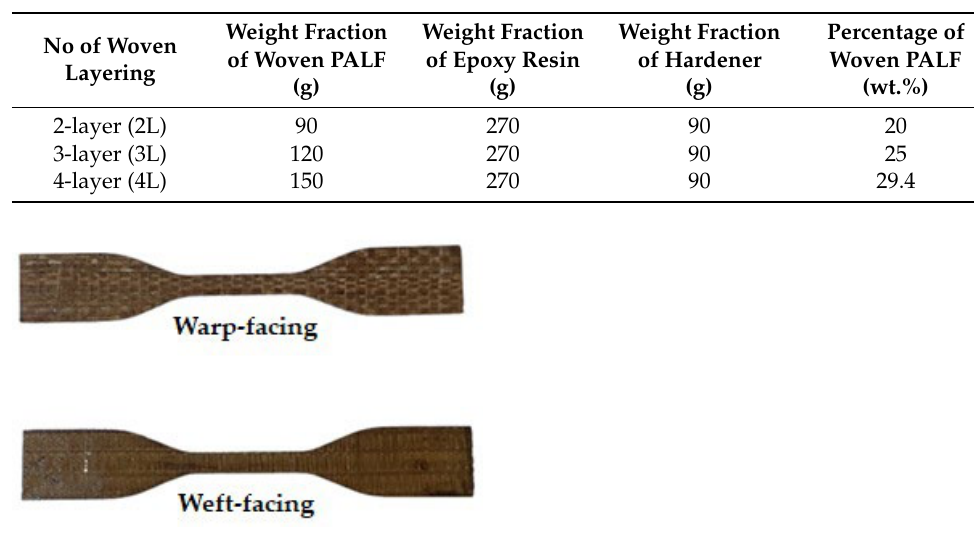
Figure 1. Warp and weft direction of woven PALF-reinforced epoxy composites.